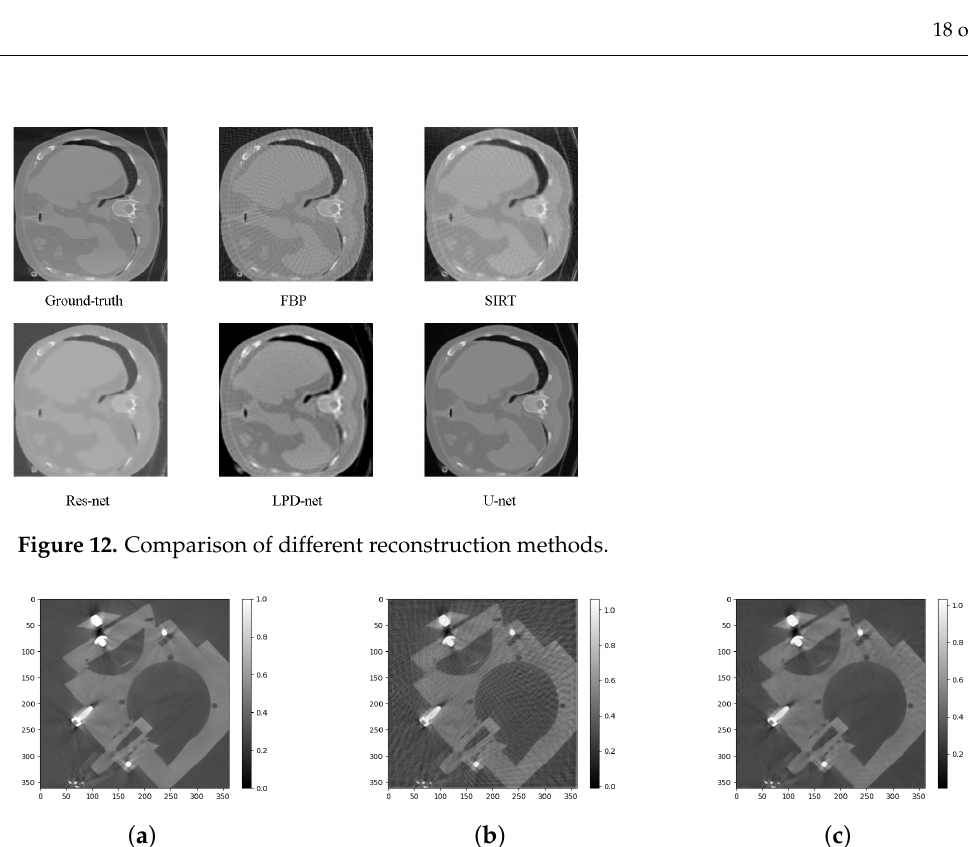
Figure 13. Industrial data reconstruction. ( a ) Ground-truth; ( b ) FBP in 60 angles; ( c ) FBP+U-net.